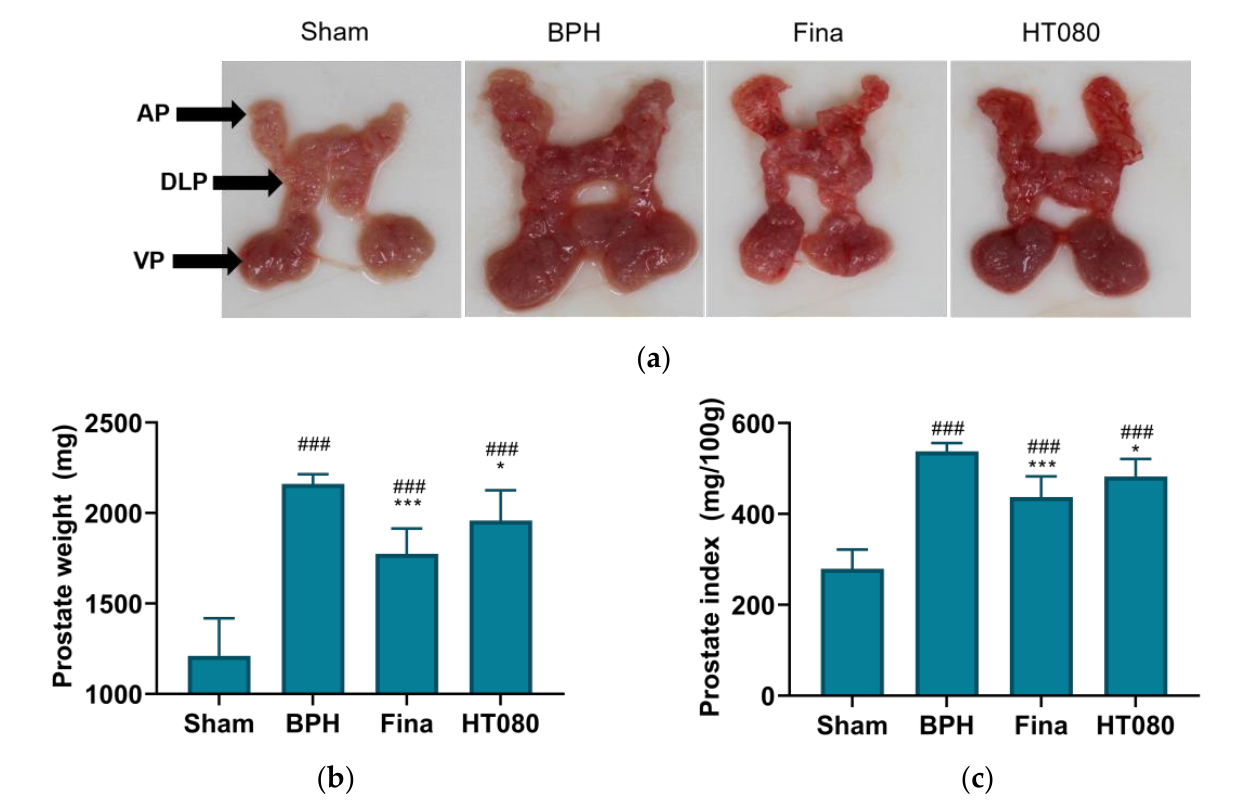
Figure 2. Effects of HT080 on prostate tissue in testosterone propionate-induced benign prostatic hyperplasia (BPH) rats. (a) Photographs of the prostate tissue (ventral prostate—VP; dorsolateral prostate—DLP; anterior prostate—AP). (b) Prostate weight of the rats. (c) Prostate index of the rats. Statistical significance: ### p < 0.001 (compared to sham group using Dunnett’s test); * p < 0.05, *** p < 0.001 (compared to BPH group using Dunnett’s test). Values are expressed as the mean ± S.D. Fina, finasteride.